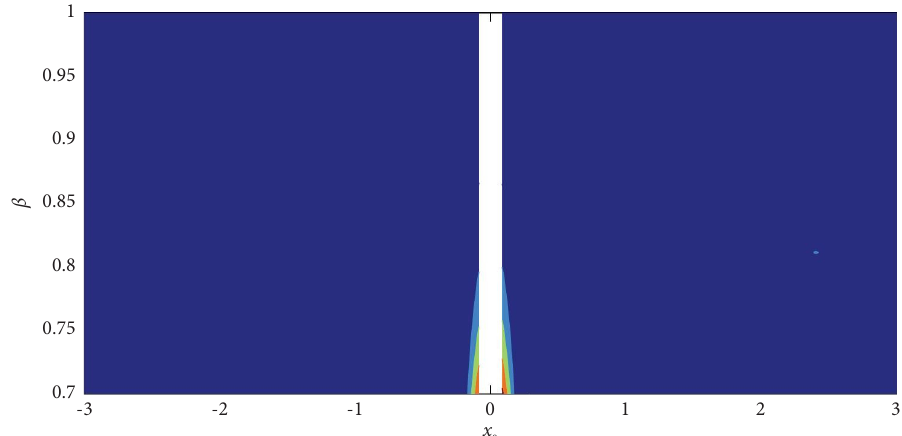
Figure 2: Convergence planes of second-order FNR on f